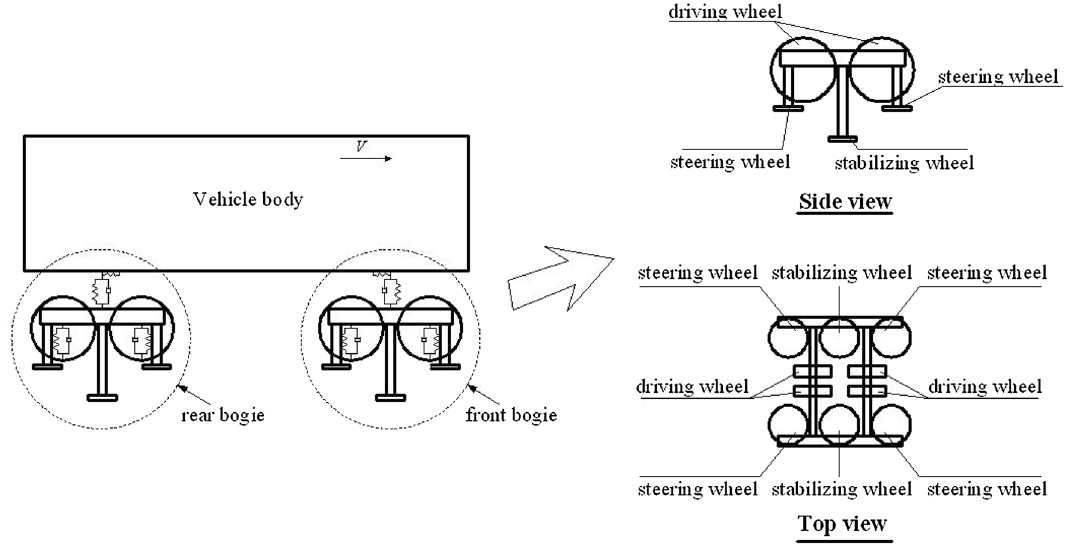
Fig. 3 Multi-rigid-body